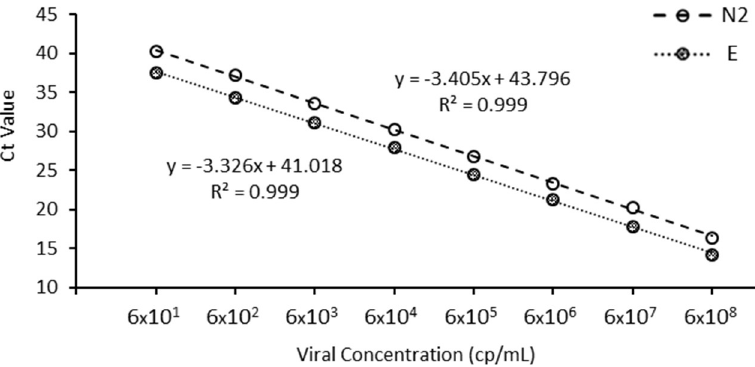
Fig 1. Standard curve for the Xpert 1 Xpress SARS-CoV-2 assay . Assay targets both the nucleocapsid (N; empty circle with a dashed line) and envelope (E; filled circle with a dotted line). The curve was produced using serially-diluted gamma-irradiated virus culture (GISAID Accession: EPI_ISL_425177) produced at the National Microbiology